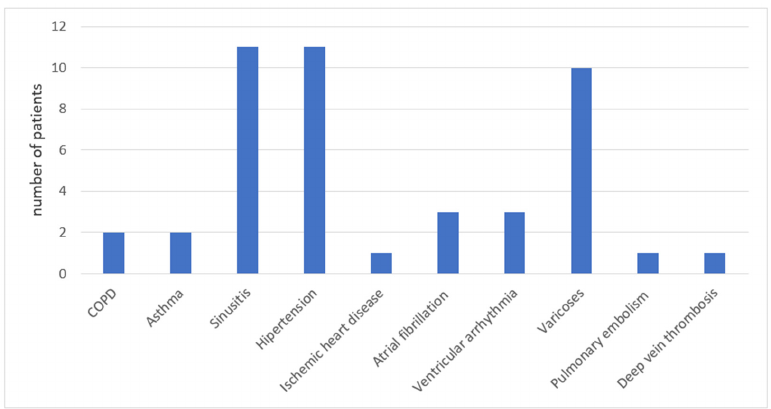
Figure 2. Group I—concomitant diseases.